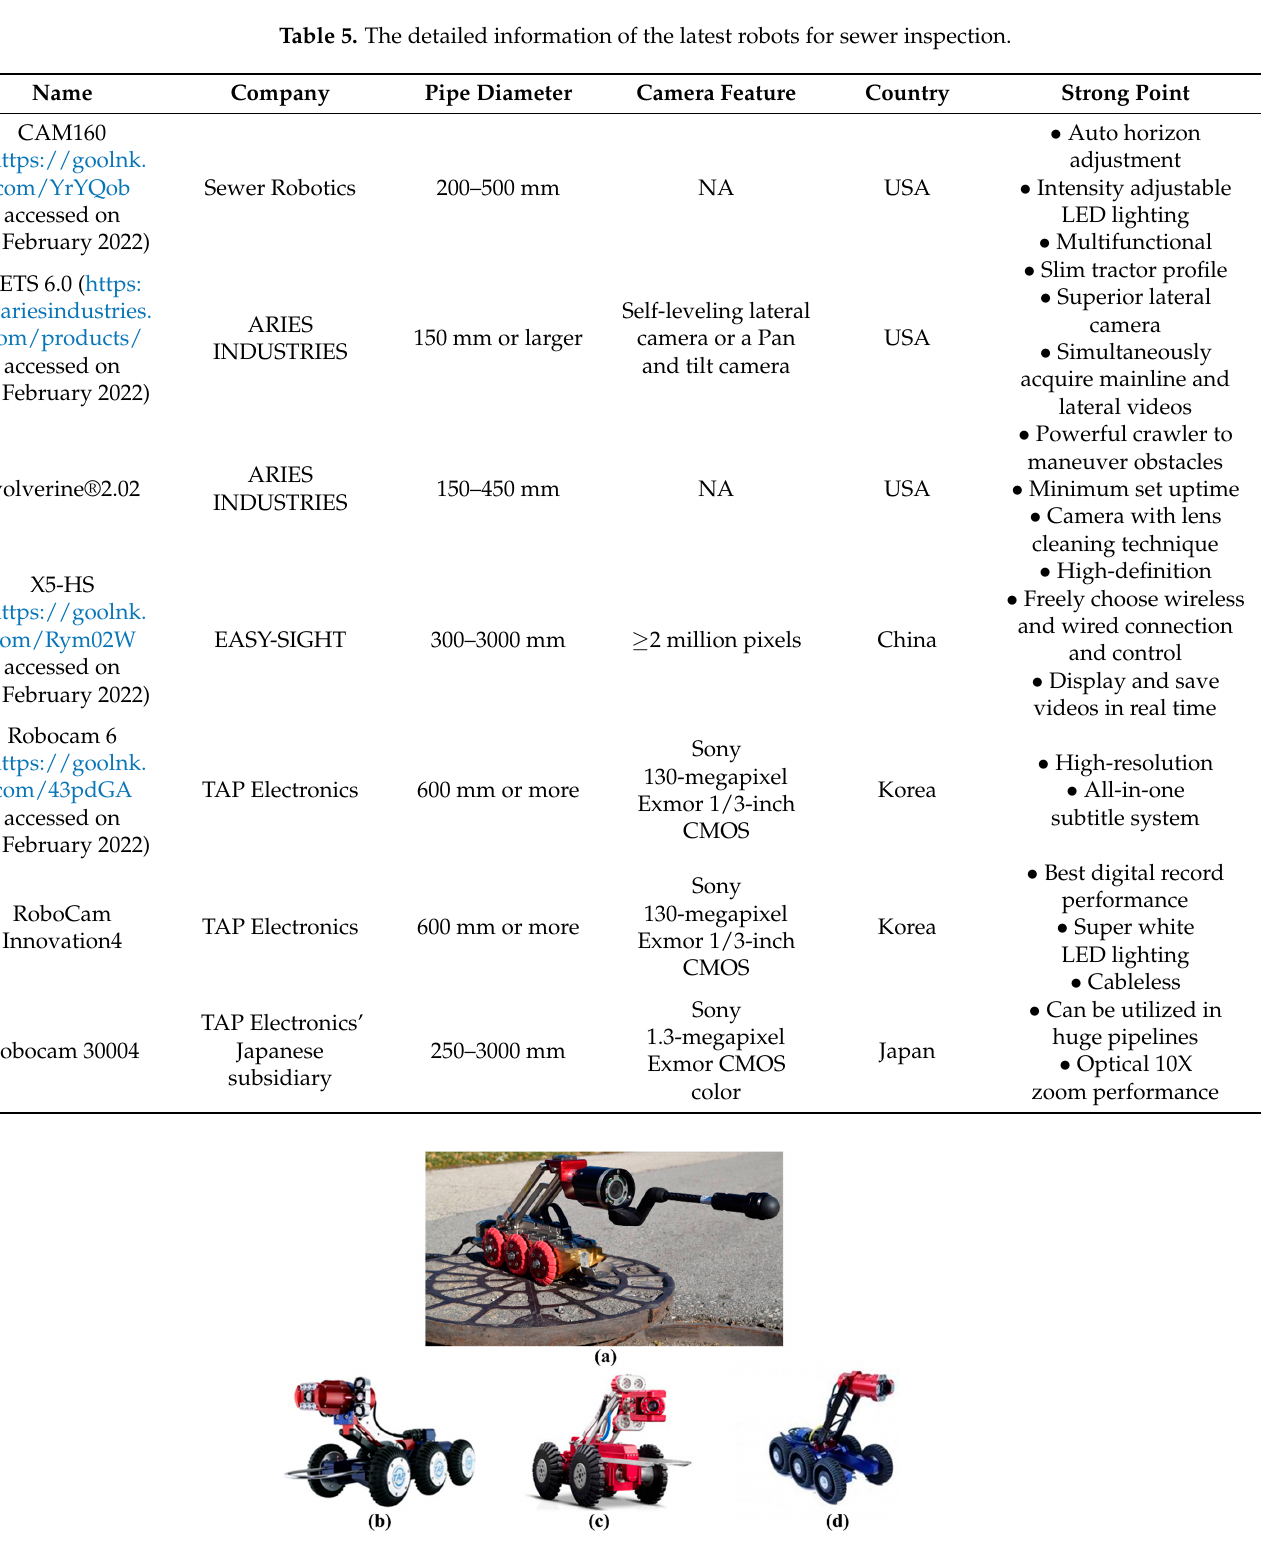
Figure 12. Representative inspection robots for data acquisition. ( a ) LETS 6.0, ( b ) Robocam 6, ( c ) X5-HS, and ( d ) Robocam 3000.